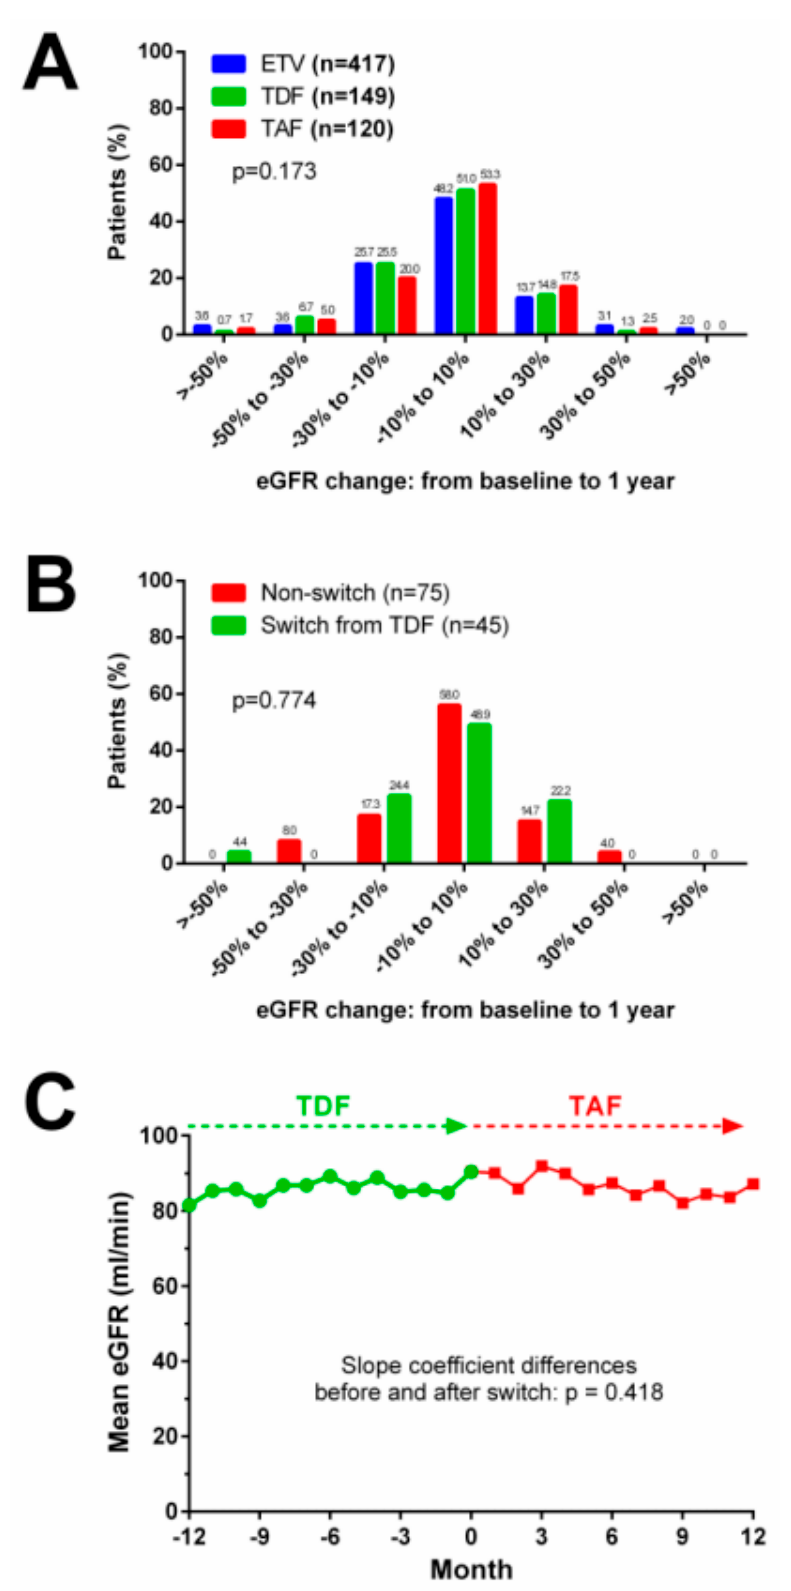
Figure 4. Patient distribution for eGFR changes from baseline to 1-year follow-up. ( A ) Distribution for eGFR changes in overall patients. ( B ) Distribution for eGFR changes in TAF-treated patients with and without switching from TDF. ( C ) eGFR changes in TAF-treated patients before and after switching from